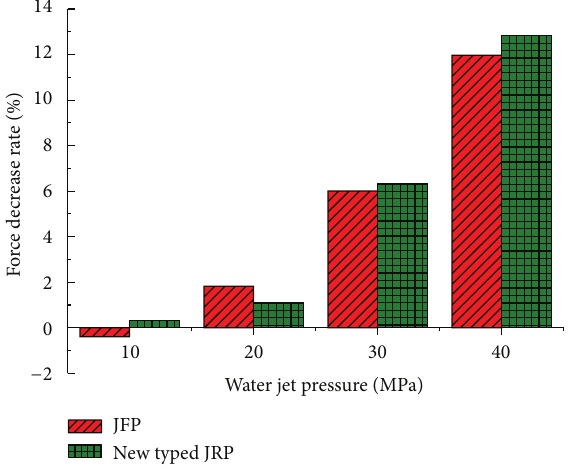
Figure 12: Cutting force decrease rates for later pick.